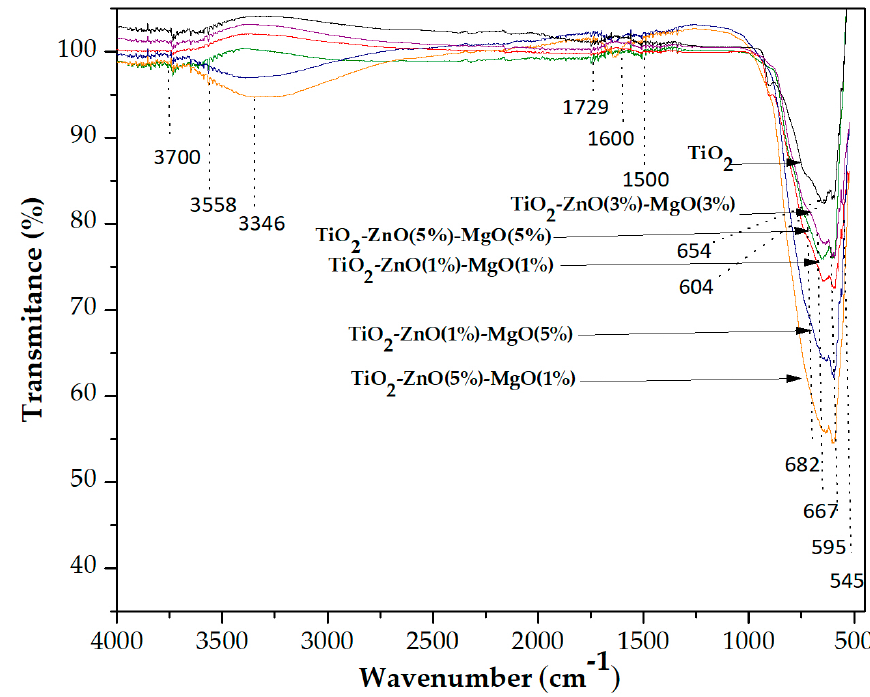
Figure 5. Fourier transform infrared spectra for TiO 2 and mixed oxide nanomaterials.